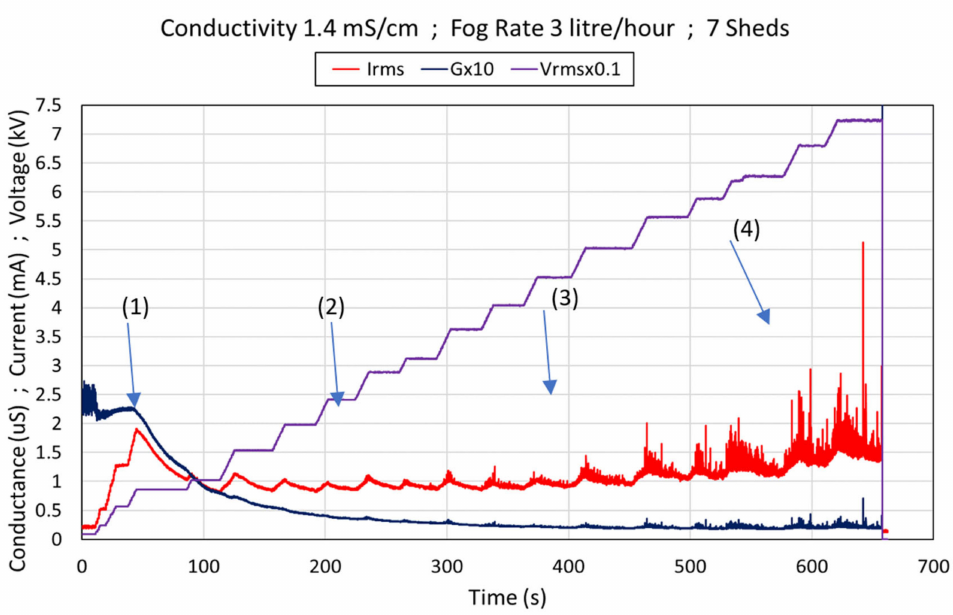
Figure 6. Surface conductance, leakage current, and applied free ramp voltage for light pollution. (1), (2) (3) and (4) are areas where LC activity and magnitude